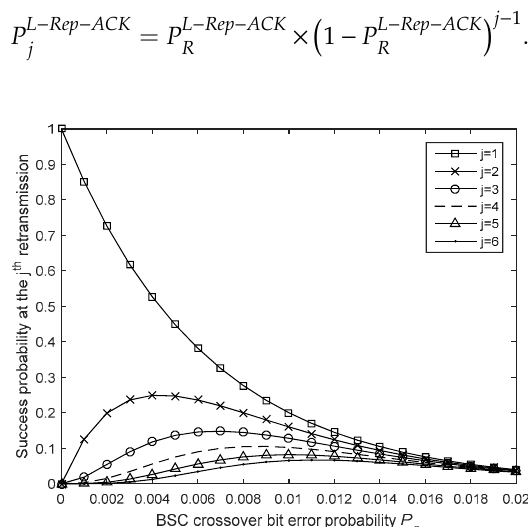
Figure 20. Packet success probability at the j th packet.